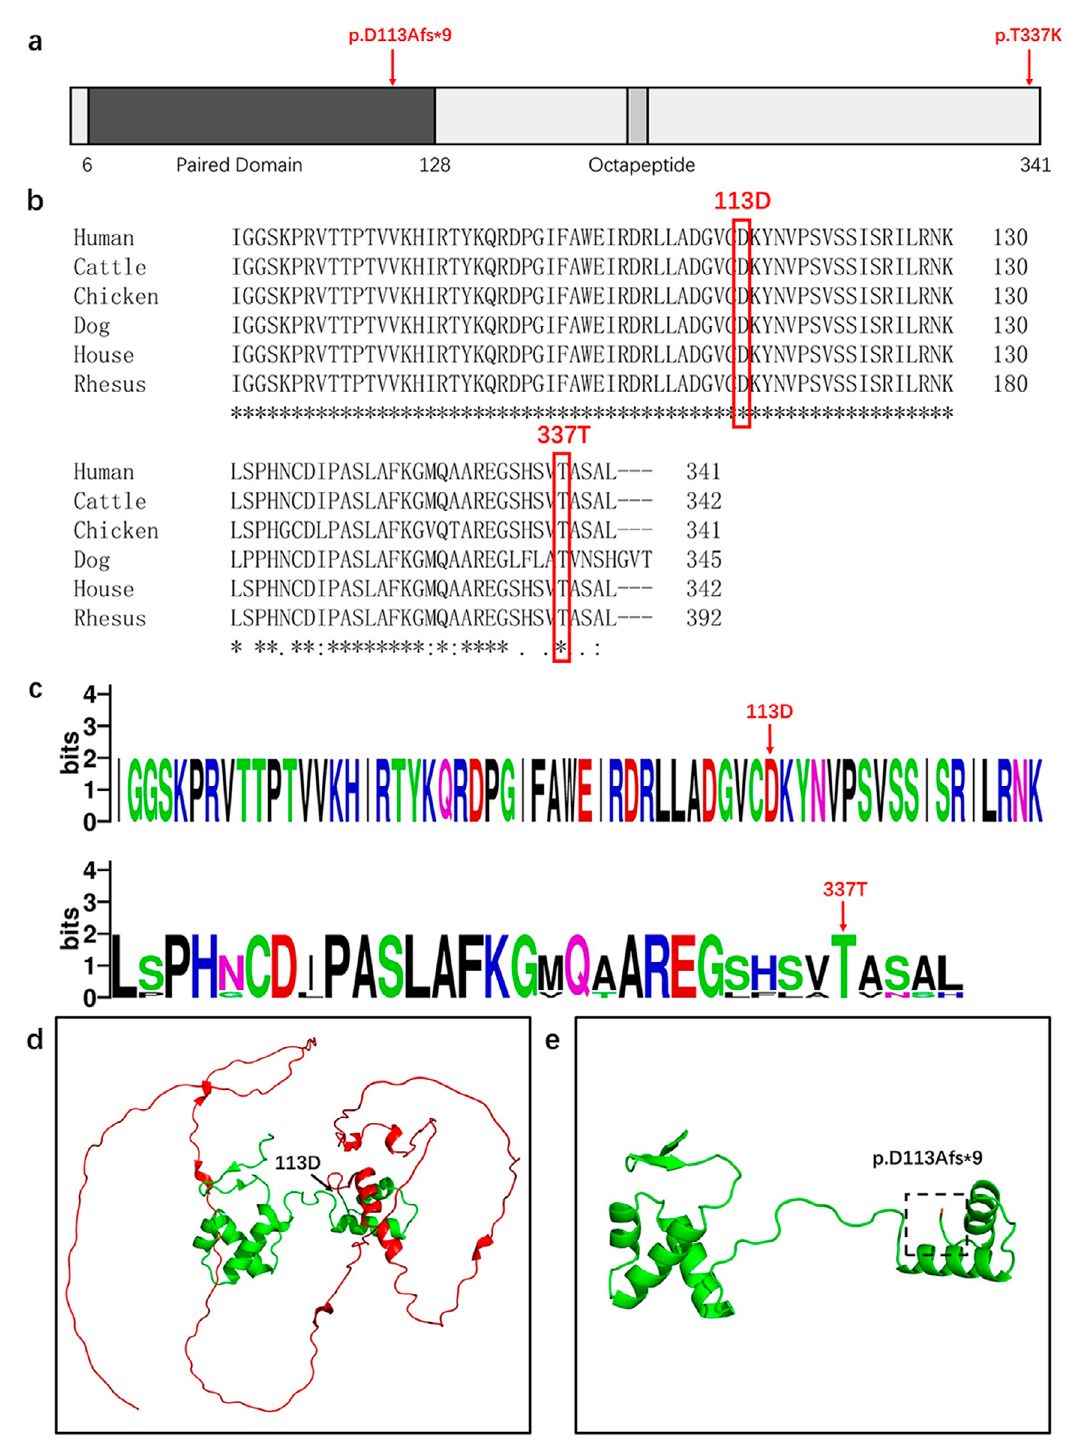
Figure 3- Conservation and bioinformatics analysis and structural modeling of PAX9 . (a) Schematic diagram of the wild-type PAX9 protein and the localization of the novel compound heterozygous PAX9 variant identified in this study. (b) Conservation analysis of PAX9 amino acid sequences in six species. (c) WebLogo analysis of PAX9 amino acid sequences in six species. (d) Structural modeling of the wild-type PAX9 protein (the amino acids encoded by the 113Afs are shown in red). (e) Structural modeling of the PAX9 p.D113Afs*9 variant (the changed amino acids are shown in